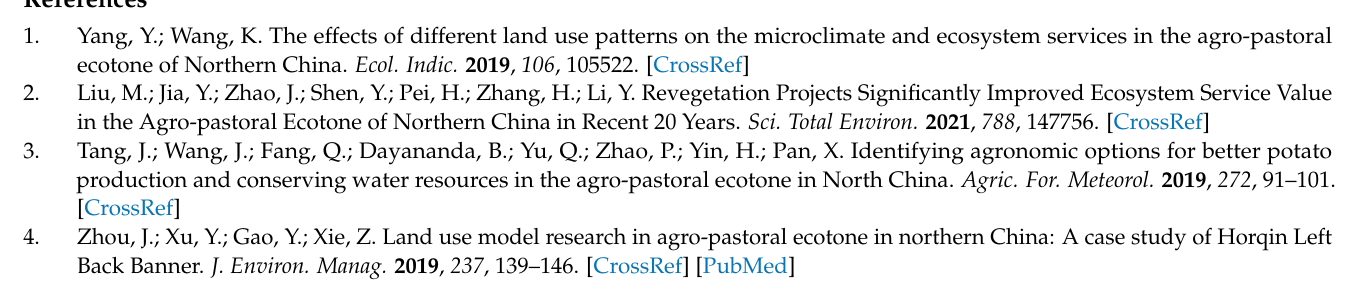
level; Figure S2. The rarefaction curves of Good’s coverage (Figure S2A), observed OTU number (Figure S2B), Shannon (Figure S2C), and Chao1 (Figure S2D) of the bacterial communities in cropland and grassland; Figure S3. The difference analysis of bacterial communities between the cropland and grassland at the phylum level via independent sample t -test. *** shows a significant difference in the bacteria between cropland and grassland at the p < 0.001 level, ** shows a significant difference at the p < 0.01 level, and * shows a significant difference at the p < 0.05 level.